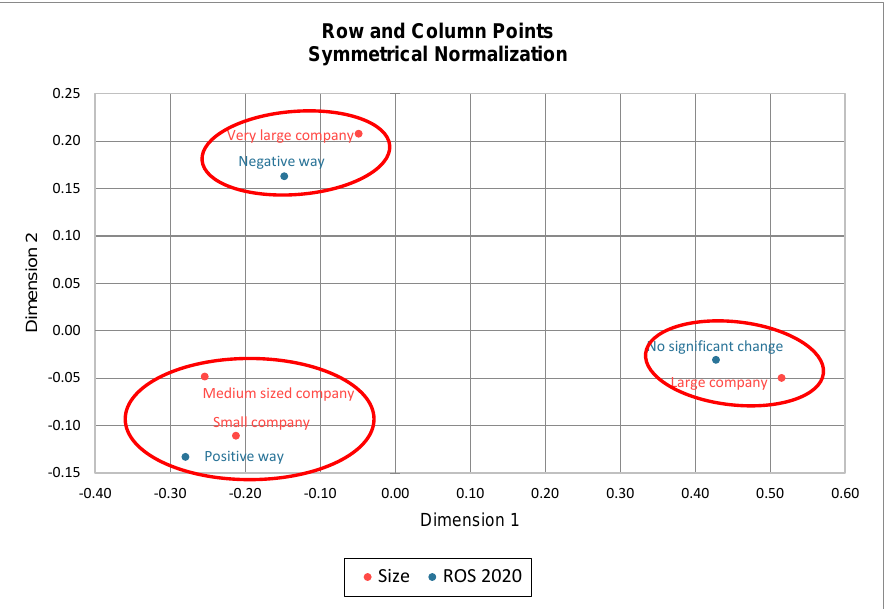
Figure 13. Correspondence map for ROS indicators in 2020 and enterprise size categories. Source: own research .